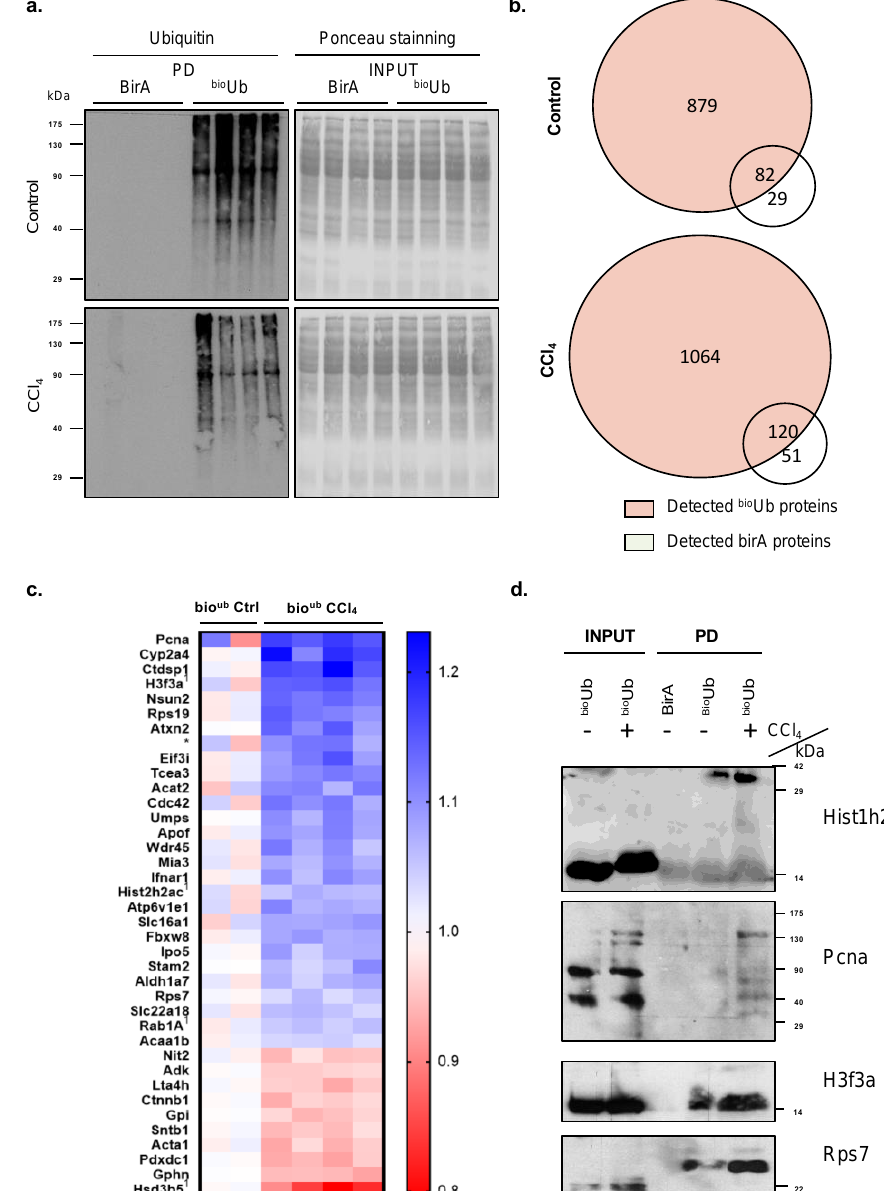
Figure 4. The ubiquitome fingerprint in carbon tetrachloride (CCl 4 )-induced liver fibrosis. Pulldown experiments were performed in the bioubiquitin transgenic mice ( bio Ub) and its controls (BirA) both under control conditions and after chronic induction of liver fibrosis through weekly injection during 6 weeks of CCl 4 . ( a ) Western blot analysis of ubiquitin levels and Ponceau staining in the pulldown (PD) fraction comparing CCl 4 animals and controls. ( b ) Venn diagram analysis comparing the total amount of identified proteins by mass spectrometry in all animals studied; ( c ) Heat map showing the significantly upregulated and downregulated ubiquitinated proteins in CCl 4 -induced liver fibrosis. *